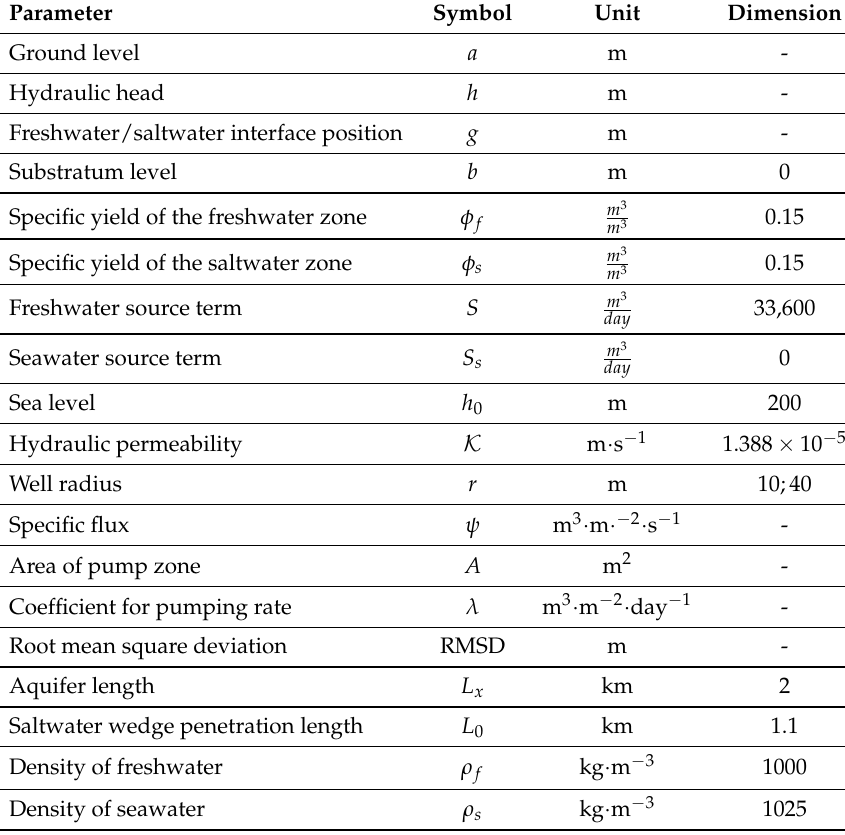
Table 1. List of used